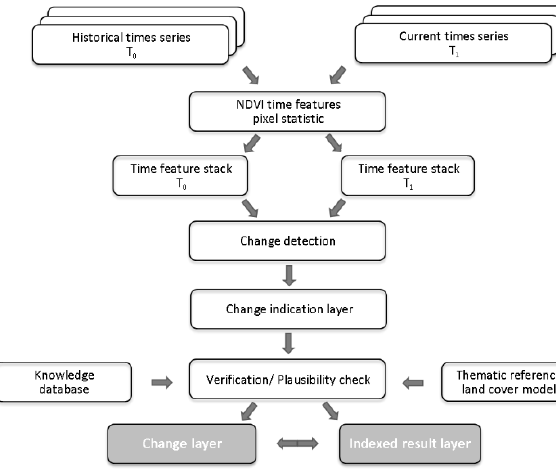
Figure 2 . LaVerDi Workflow for automatic change detection.